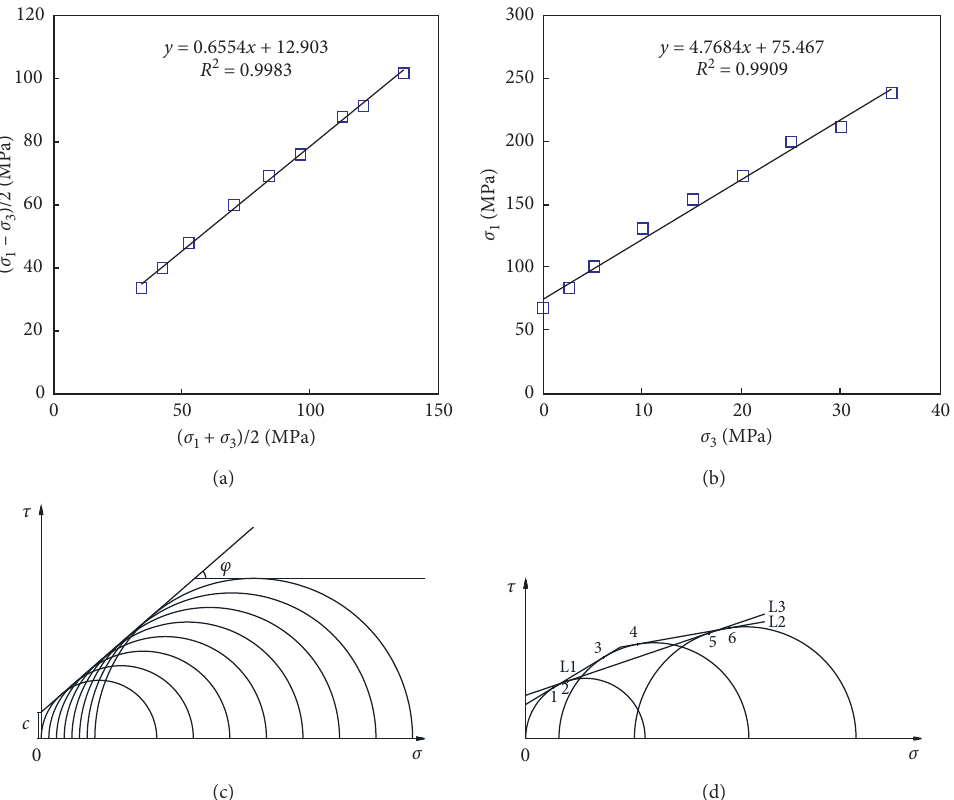
Figure 1: Methods of obtaining strength criteria. (a) The method by Stafford et al. [4]. (b) A linear curve in the common method. (c) Mohr’s circles in the common method. (d) The method by Wang